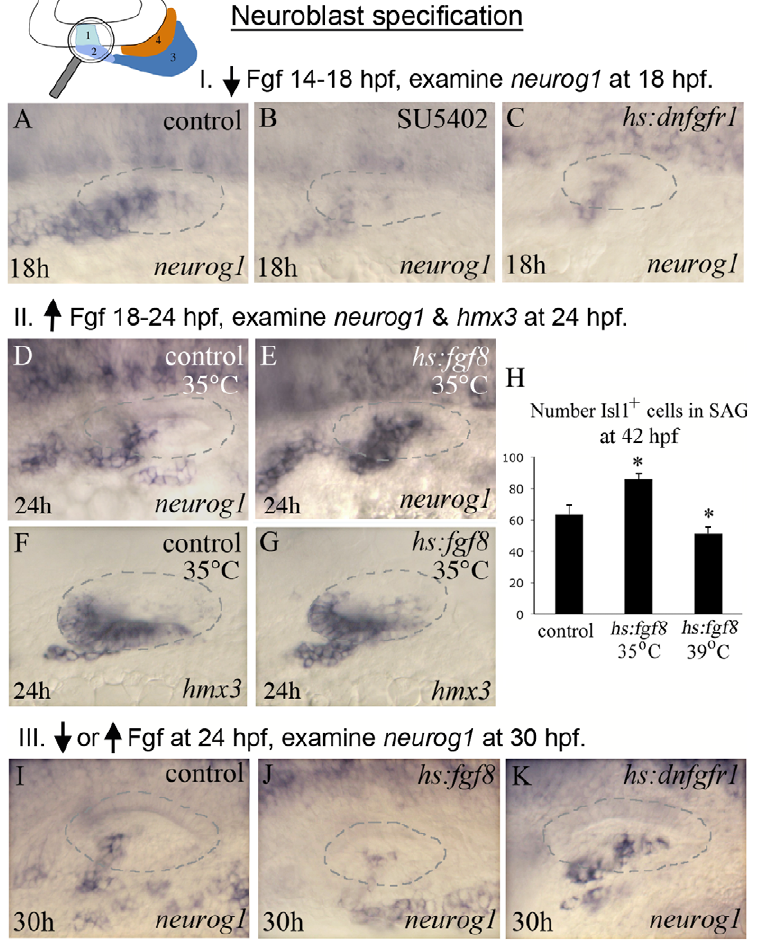
Figure 4. Fgf regulates neuroblast specification. The icon at the top of the figure indicates that analysis focuses on initial stages of neuroblast formation, as normally marked by neurog1 expression. Experimental manipulations in groups I, II and III are briefly summarized at the tops of the corresponding data panels. (A–C) Experiment I, neurog1 expression at 18 hpf in a control (A), SU5402 inhibitor treated (B) and hs:dnfgfr1/ + transgenic embryo heat shocked for 30 minutes at 38 u C beginning at 14 hpf. Blocking Fgf strongly reduces expression of neurog1 . (D–G) Experiment II, expression of neurog1 (D–E) and hmx3 (F–G) in control and hs:fgf8/ + embryos heat shocked at 35 u C for 6 hours, from 18 hpf until 24 hpf. This regimen results in weak overexpression of Fgf8, which at this stage enhances expression of neurog1 . (H) Experiment II, total number of Islet1-positive cells in the SAG (mean and standard deviation, n=15) at 42 hpf following heat shock activation of hs:fgf8 at 18 hpf at indicated temperatures. Weak misexpression of Fgf8 (35 u C) increases production of SAG neurons whereas strong misexpression of Fgf8 (39 u C) reduces production of SAG neurons. *p , 0.001 in comparison to the control, analyzed with Student’s t test. (I–K) Group III, neurog1 expression at 30 hpf following heat shock at 24 hpf in control embryos (I), hs:fgf8/ + embryos heat shocked at 39 u C for 30 minutes to strongly over-express Fgf (J) and hs:dnfgfr1/ + embryos heat shocked